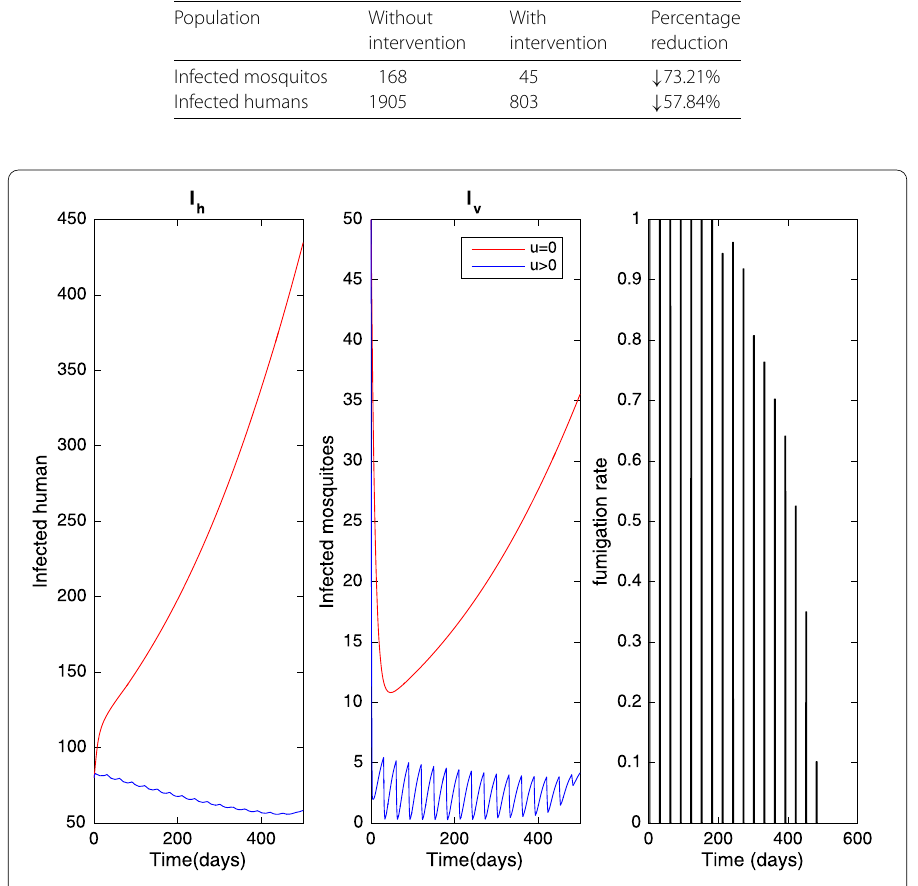
Table 6 The numbers of each population of infected individuals on the 500th day of the endemic reduction scenario